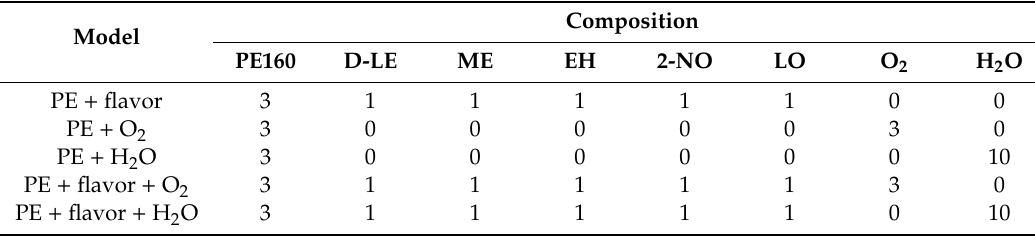
Table 1. Composition of the amorphous cells